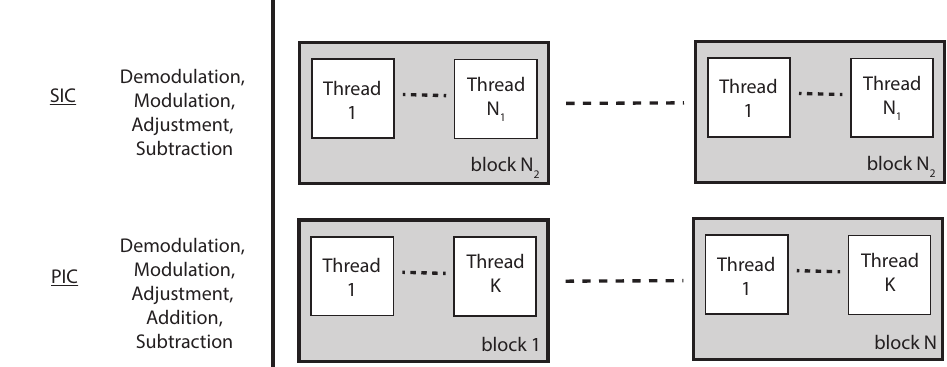
Figure 3. Functions and kernels for SIC and PIC using